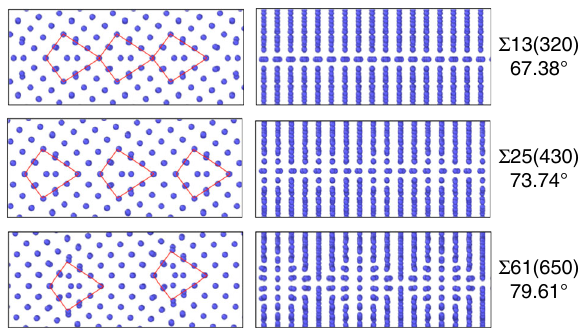
Fig. 5 Extended Kite family. Extended Kite phases of three representative boundaries predicted by the evolutionary search at 0 K. The misorientation angles are indicated on the fi gure. For each misorientation GB structures as viewed parallel to the [001] tilt axis (left column) and normal to it (right column). Extended Kites have higher atomic density compare to Kites, which correspond to half of the atomic plane. The structural units are outlined and change their separation with the increasing misorientation angle